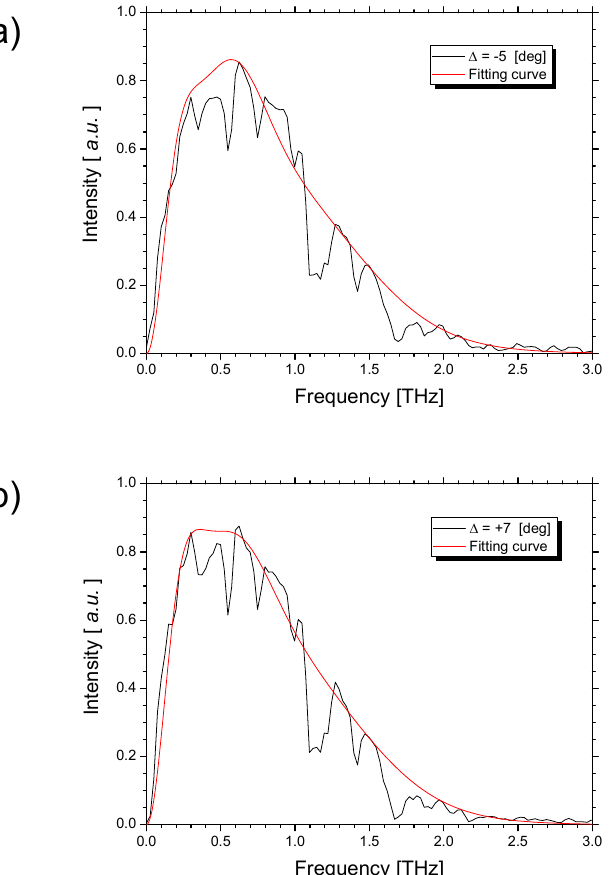
Figure 11. Fitting curves for the CER spectra at ( a ) ∆ = −5° and ( b ) ∆ = +7° (red curves). The measured spectra are indicated by black curves in the figures.